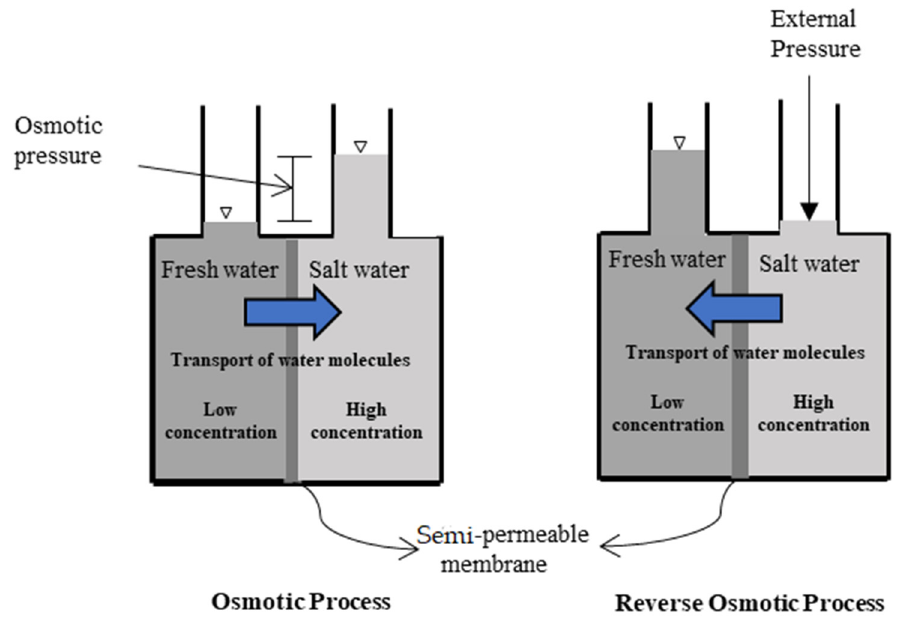
Figure 1. Schematic diagram of water flow in FO and RO processes.